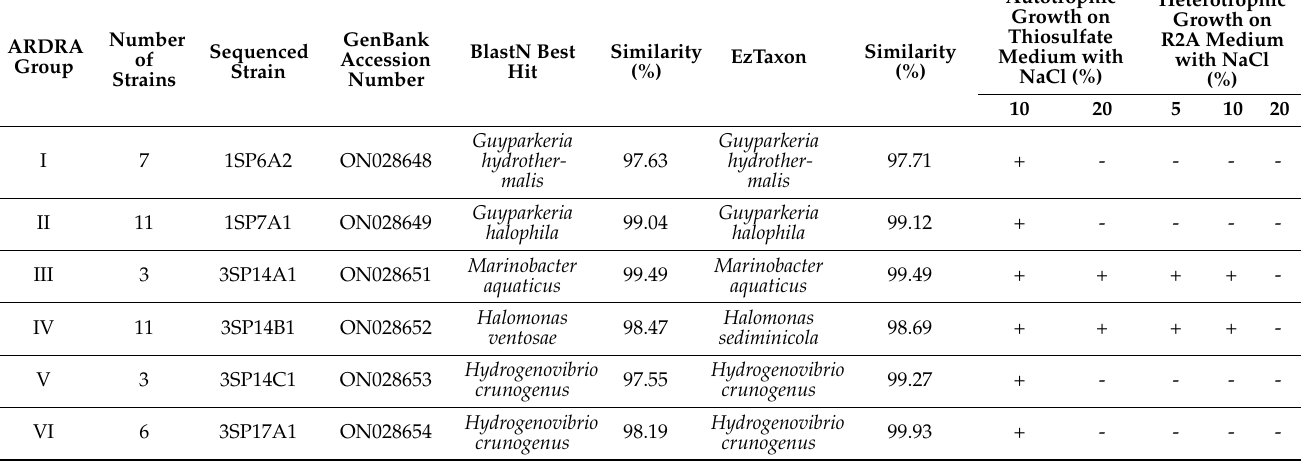
Table 1. Identification of representatives of ARDRA (Amplified Ribosomal DNA Restriction Analysis) groups based on 16S rRNA gene sequencing and results of cultivation analysis using different concentrations of